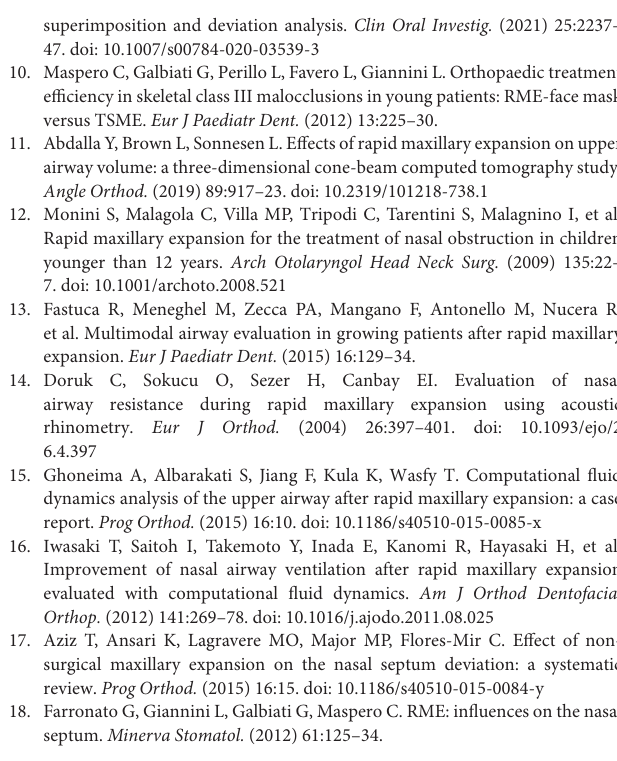
Supplementary Figure 1 | Experimental airway model with pressure taps locations. Supplementary Figure 2 | Comparison of wall static pressure between experiments and three different CFD models. Supplementary Table 1 | Statistical comparisons of morphological measurement. Supplementary Table 2 | Grid independence